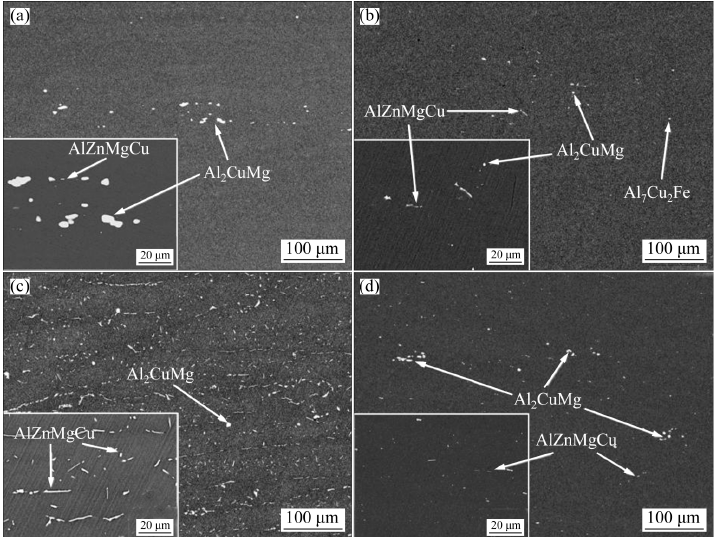
Figure 21. Second-phase distribution after different solid solution treatments in 7055: ( a ) SST; ( b ) EST; ( c ) HTPP; ( d ) MST. Adapted with permission from ref. [105]. 2021 Zhang et al.